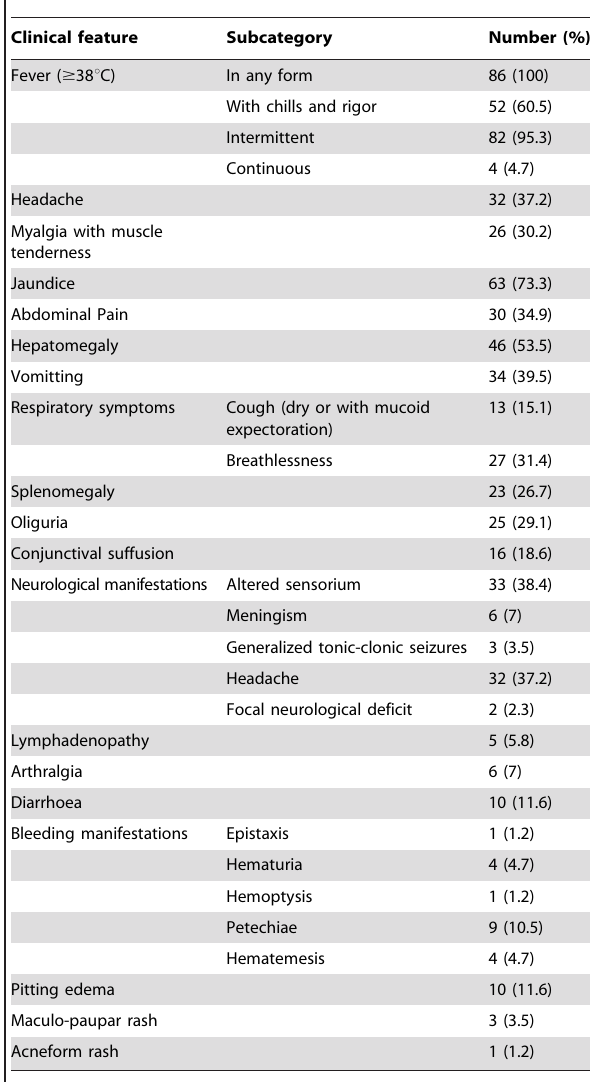
Table 3. Epidemiological risk factors found in the 86 leptospirosis patients.